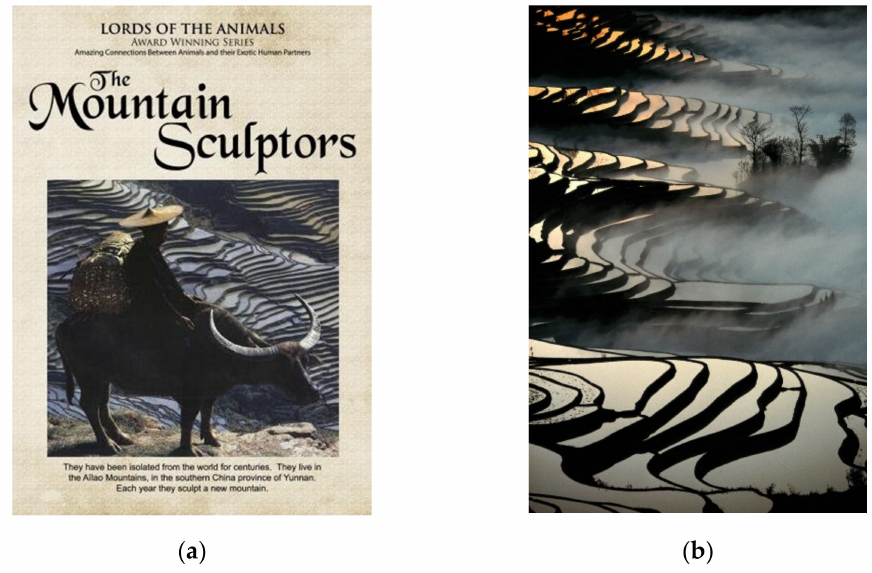
Figure 7. The mountain sculptors: ( a ) cover of the photo album; ( b ) a photo of Hani terraces by Yann